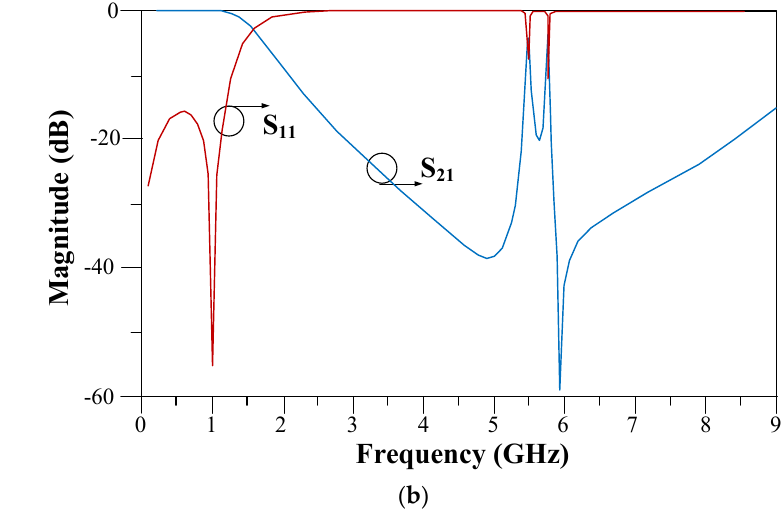
Figure 11. Final vertical resonator: ( a ) layout and ( b ) frequency response. All dimensions are in the millimeter unit.